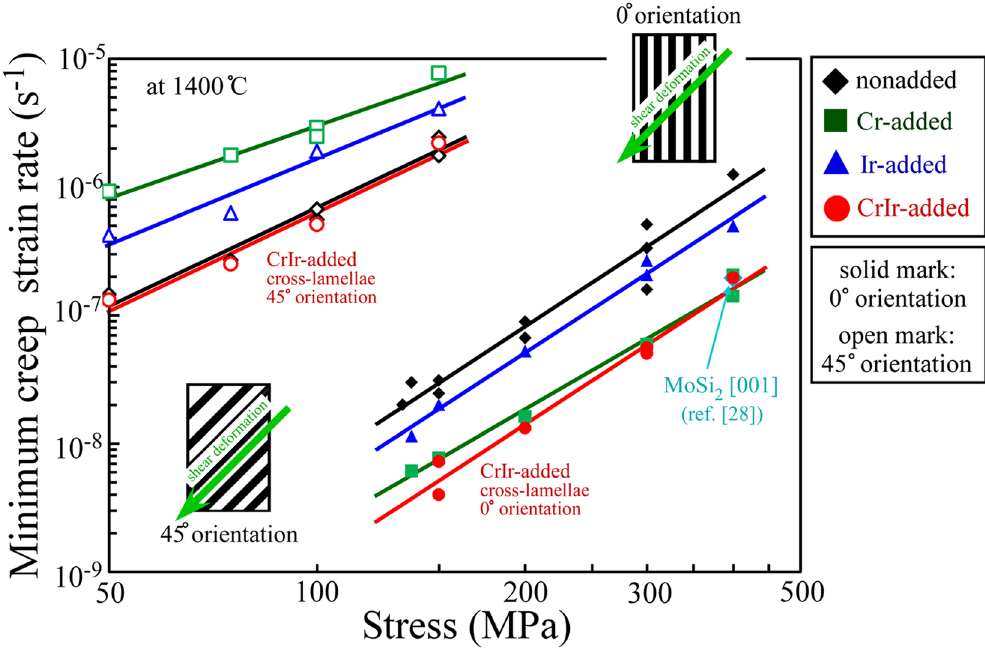
Figure 6. Summary of the creep strength in the lamellar crystals. Variations in the MCR with the applied stress and loading orientation in the creep tests at 1400 °C for the various (Mo 0.85 Nb 0.15 )Si 2 -based crystals investigated in this study are indicated.